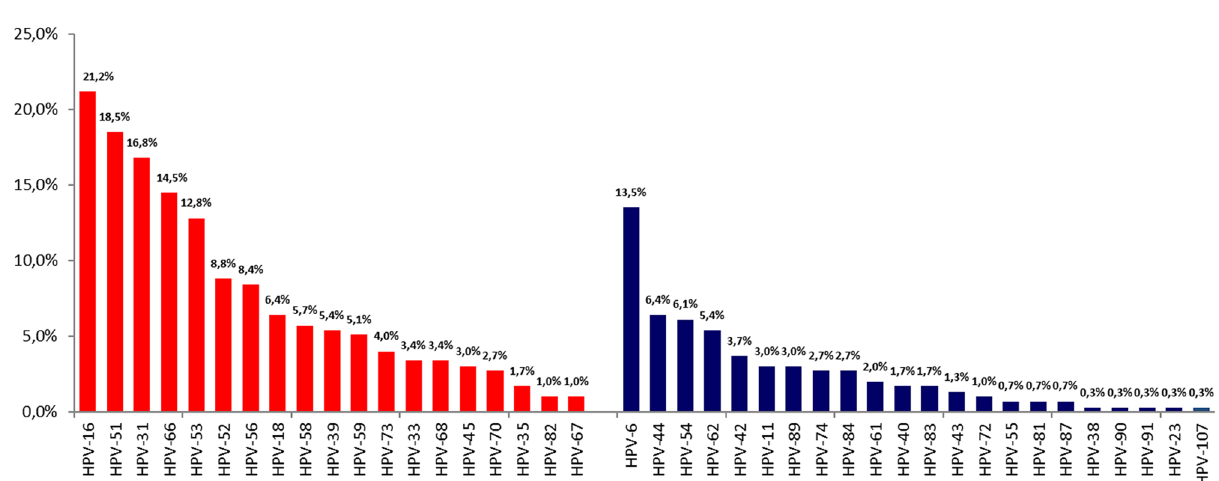
Figure 3. Type-specific distribution of hihrHPV (red) and lrHPV (blue) among 297 men HPV + with HPV positive partner (Group III).